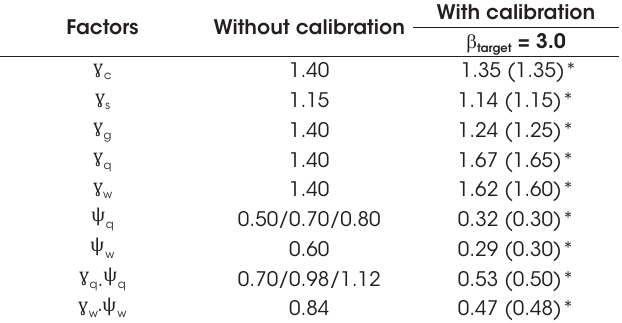
Partial safety factors with and without calibration for flexural resistance of reinforced concrete